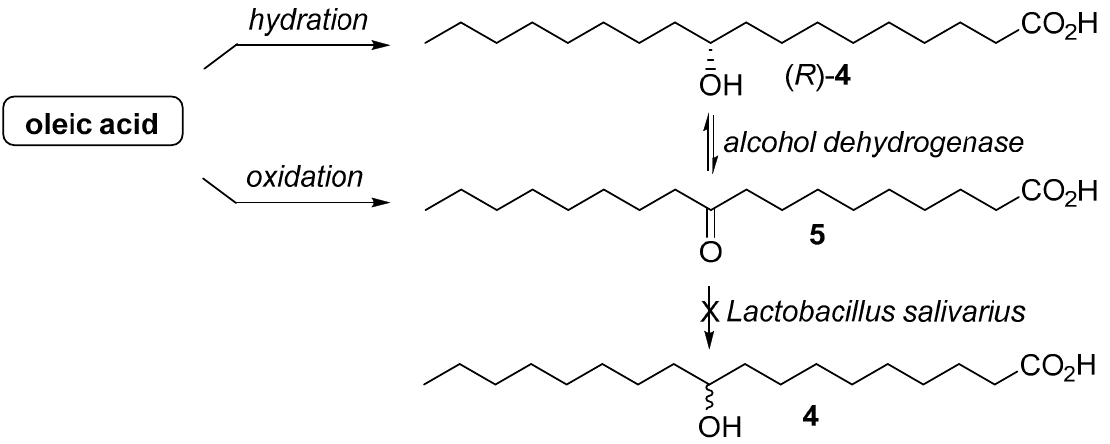
Figure 3. Two possible biosynthetic pathways involved in the Lactobacillus salivarius mediated transformation of oleic acid into 10-HSA ( 4 ) and 10-KSA ( 5 ).